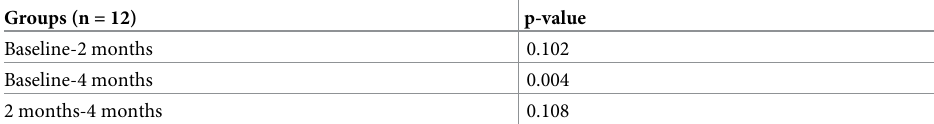
Table 4. Differences in IgG antibody levels (Euroimmun 1 ELISA) for IgG-positive children between time points. Groups (n =